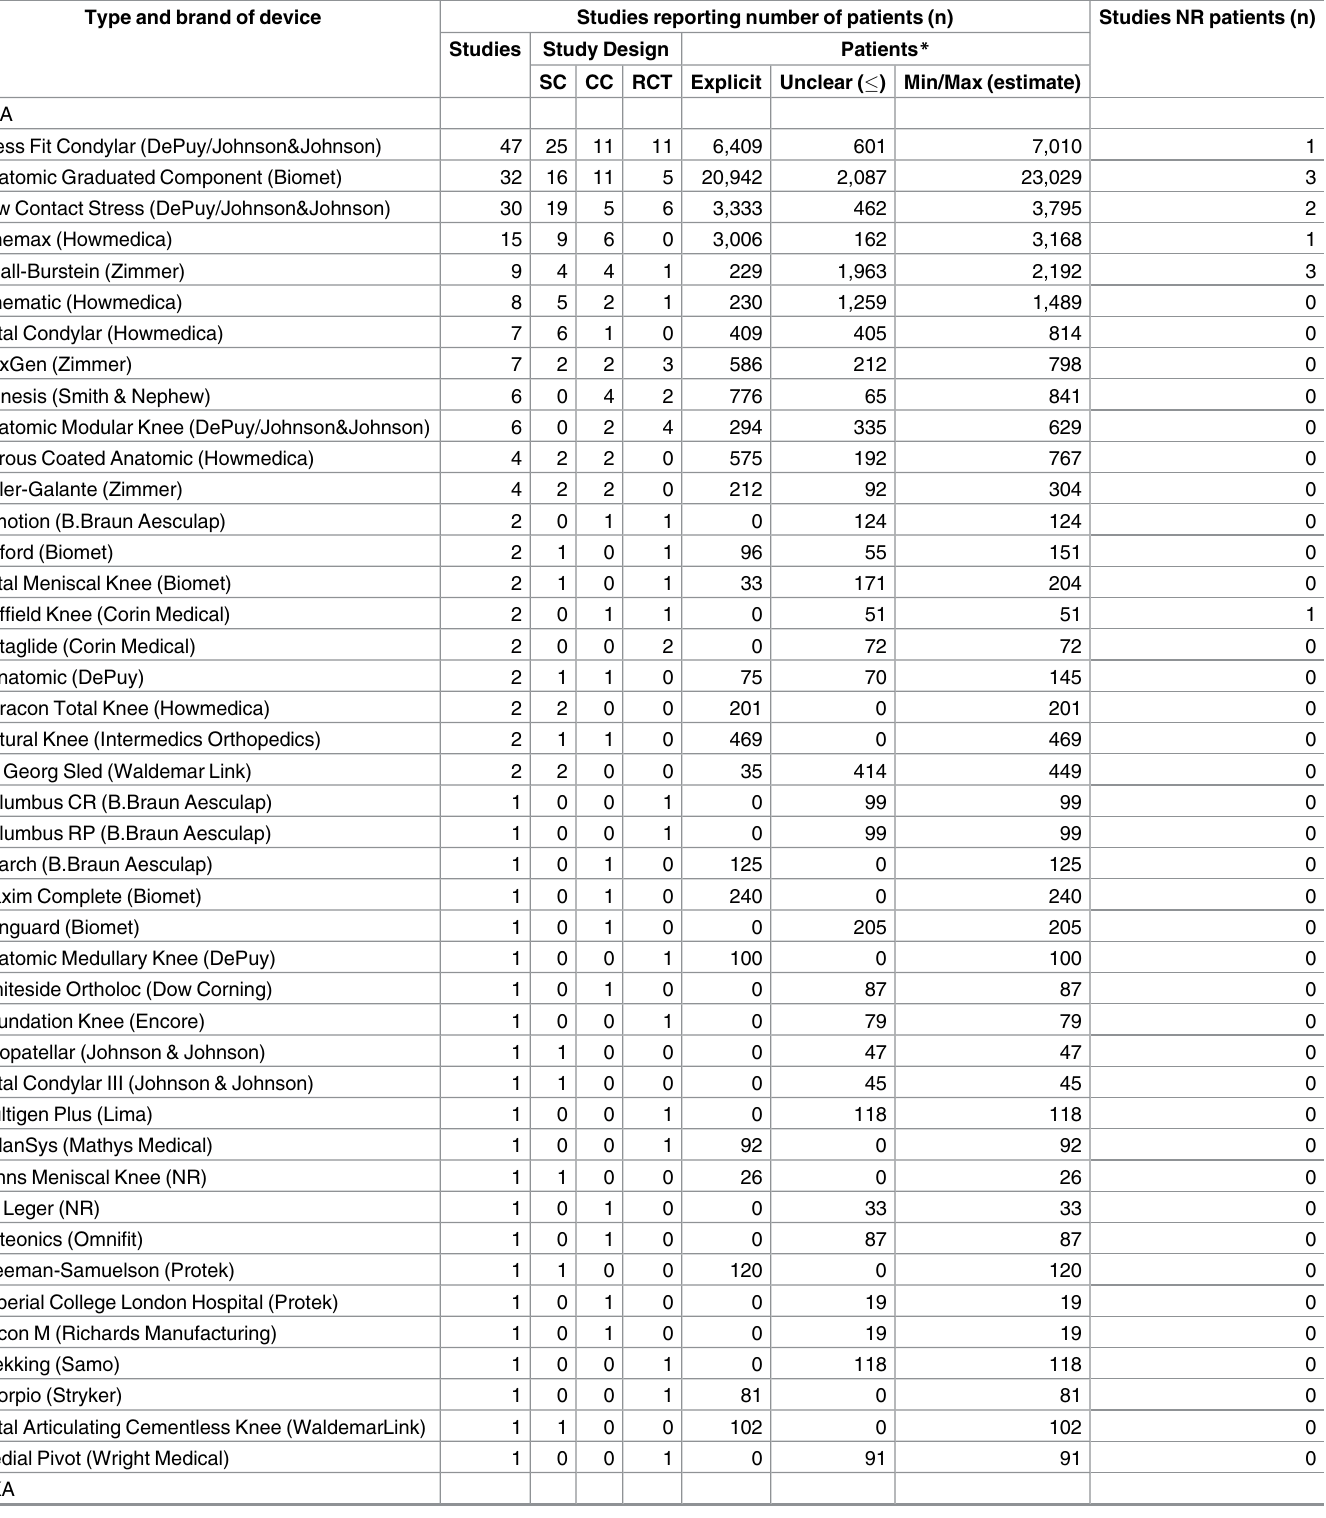
Table 2. Implants evaluated in eligible